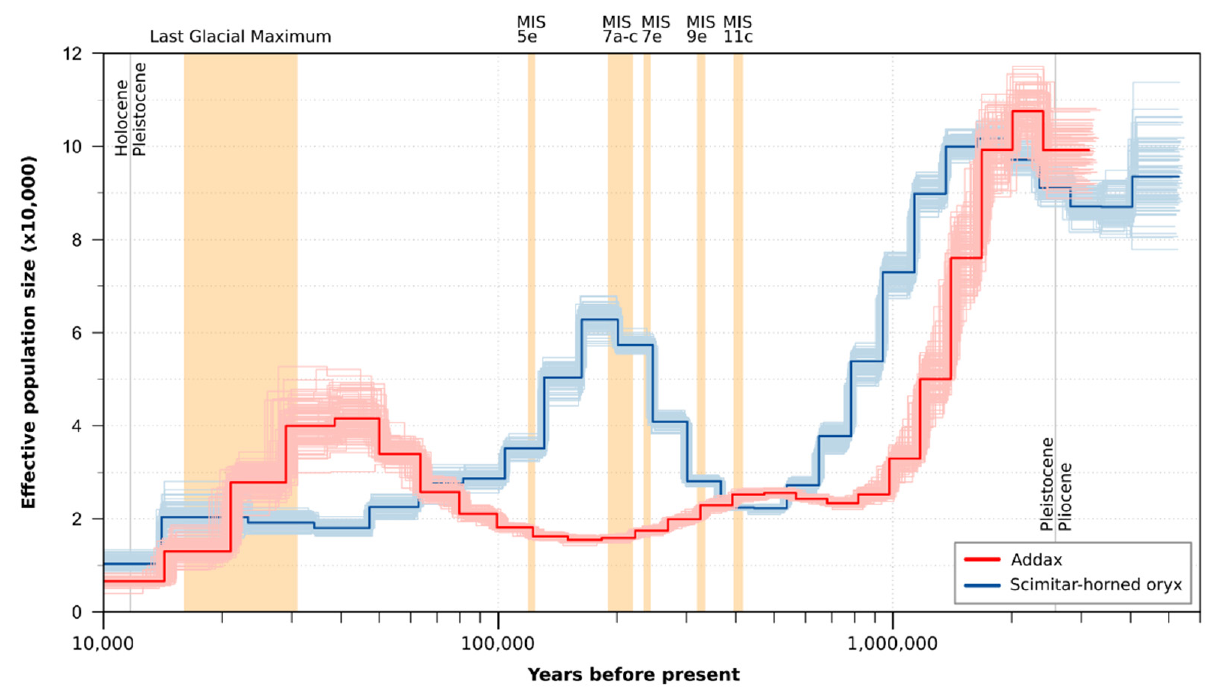
Figure 3. Pairwise sequential Markovian coalescent model for the addax and the scimitar-horned oryx. Changes in effective population size N e (with 100 bootstrap repetitions) in the addax and the scimitar-horned oryx based on an autosomal pairwise sequential Markovian coalescent model (addax: generation time 6.8 years, mutation rate per generation ( µ ) 1.09 × 10 − 8 [59], this study; scimitar-horned oryx: generation time 6.2 years, mutation rate per generation ( µ ) 9.95 × 10 − 9 [60], this study). Last Glacial Maximum and Marine Isotope Stages (MIS) representing interglacial periods of the last 500,000 years are marked in light orange. Note the Late Pleistocene reduction in population size, approximately coinciding with the age of the most recent common ancestor of the mitochondrial genome samples (Figures 4 and 5). Scimitar-horned oryx data from Humble et al. [53]. See Figure S1 for a presentation of the results on a linear time scale.